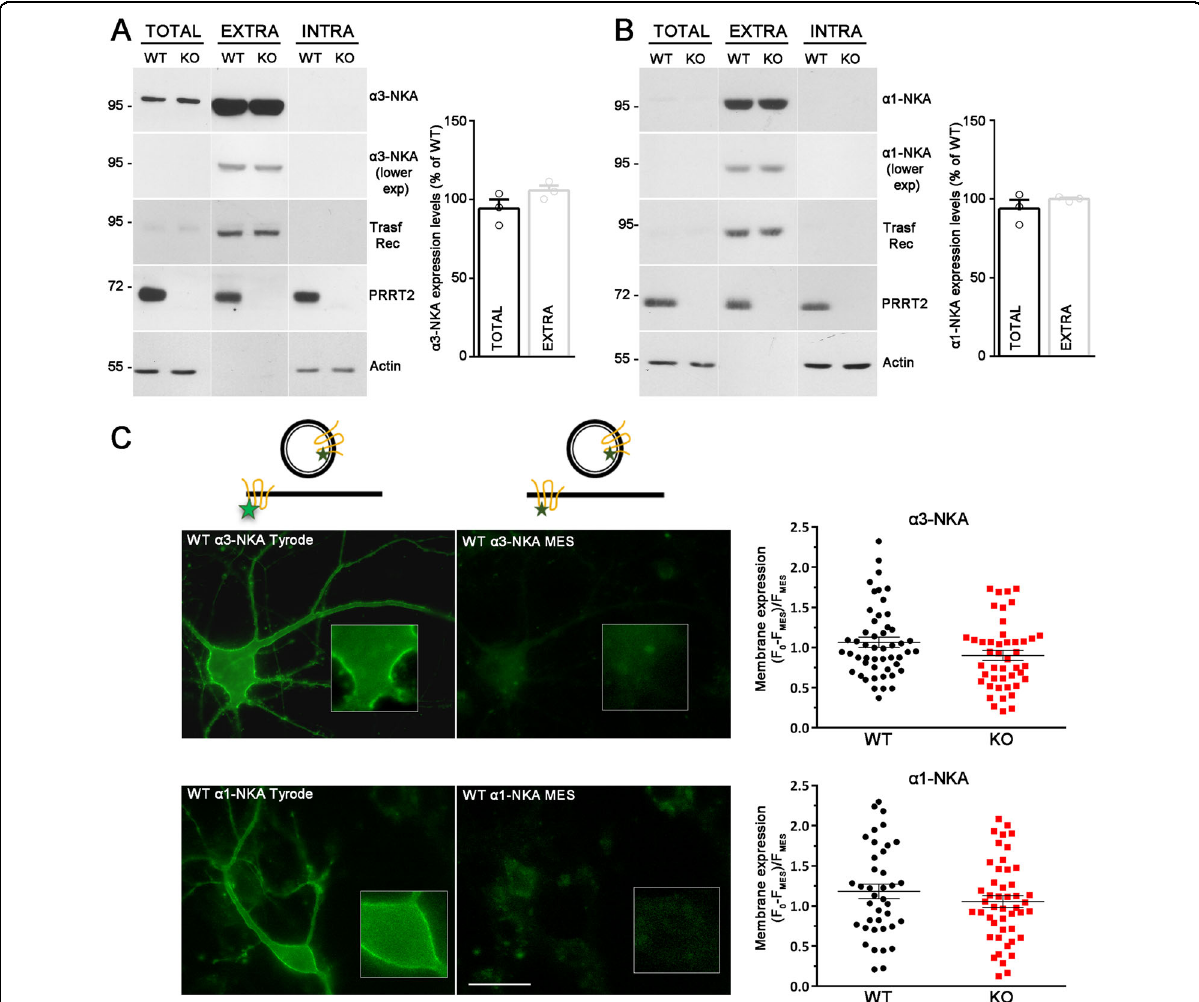
Fig. 3 PRRT2 does not affect NKA expression level at the membrane surface. A , B Left: Representative immunoblots of cell surface biotinylation performed in WT and PRRT2 KO hippocampal neurons. Total lysates (TOTAL), biotinylated (cell surface, EXTRA), and non-biotinylated (intracellular, INTRA) fractions were analyzed by western blotting with antibodies to PRRT2 and either α 3-NKA ( A ) or α 1-NKA ( B ). Antibodies to transferrin receptor (Transf Rec) and actin were used as markers of cell surface and intracellular fractions, respectively. Vertical lines in the blot indicate that the lanes were on the same gel but have been repositioned in the fi gure. Right: Total and cell surface α 3-NKA ( A ) and α 1-NKA ( B ) immunoreactivities are expressed in percent of the respective WT value after normalization to Transferrin receptor (for the EXTRA fraction) or actin (for the INTRA fraction). Means± SEM of n = 3 independent experiments; unpaired Mann – Whitney ’ s U -test. C , D Left : Representative images of a WT neuron transfected with α 3-NKA-SEP ( C ) or α 1-NKA-SEP ( D ) perfused with Tyrode followed by MES buffers (scale bar, 20 μ m). Insets show higher magni fi cation of the fl uorescence at the plasma membrane where ROIs were measured. The cartoons shown on top depict the SEP state under Tyrode and MES buffers, respectively. The green stars represent fl uorescent emission of the chimeric protein, which is quenched at acidic pH, i.e., in acidic intracellular compartments and in the presence of extracellular MES buffer. Right: Membrane expression of α 3-NKA-SEP ( C ) and α 1-NKA-SEP ( D ) in WT and PRRT2 KO neurons, calculated as the normalized difference between fl uorescence in Tyrode ( F 0 ) and fl uorescence in MES ( F MES ) as [( F 0 − F MES )/ F MES ]. Data are means± SEM of 40 – 51 neurons, obtained from n = 3 independent preparations for WT and PRRT2 KO,